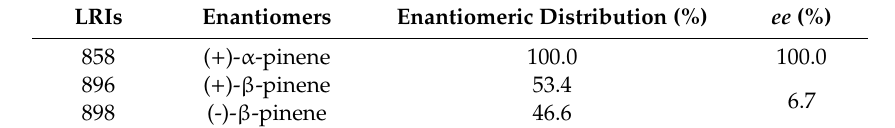
Table 2. Enantioselective analysis of S. echinata essential oil on diacethyl terbutylsilyl- β -cyclodextrin column.